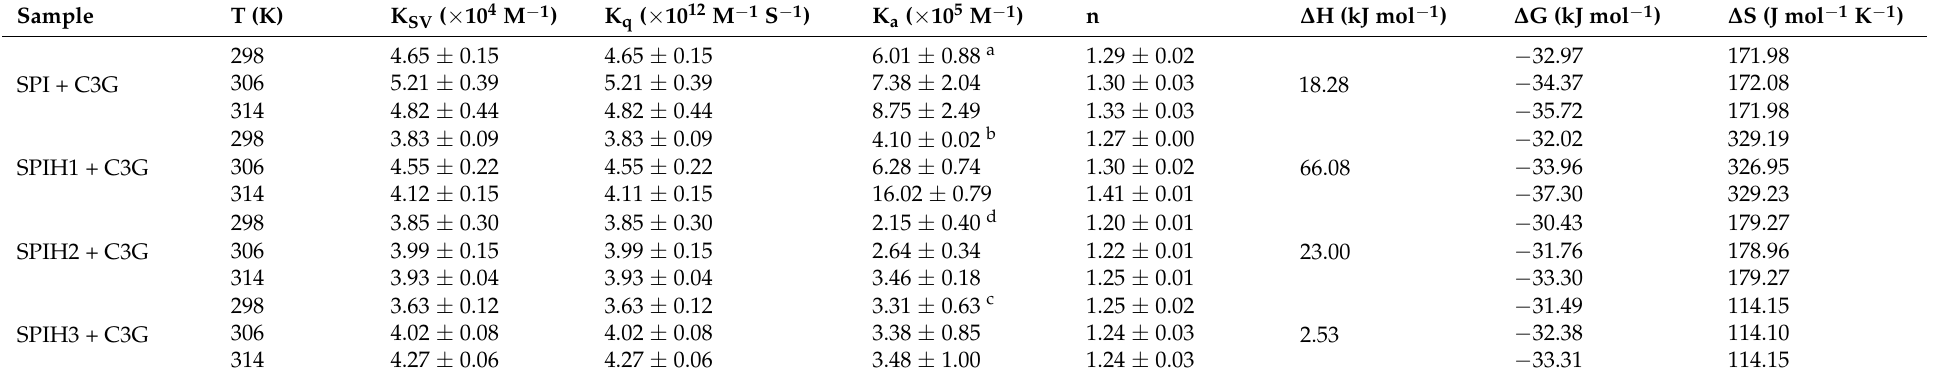
Figure 1. Intrinsic fluorescence spectra of 0.4 mg/mL SPI ( A ) and SPIH1-3 ( B – D ) in the presence of 0, 10, 20, 40, 60, 80, and 100 µ M C3G (0–6) at 298 K at pH 7.0. Table 2. The quenching constants, binding constants, number of binding sites, and thermodynamic parameters for 0.4 mg/mL SPI/SPIHs in the presence of 0, 10, 20, 40, 60, 80, and 100 µ M C3G at 298, 306, and 314